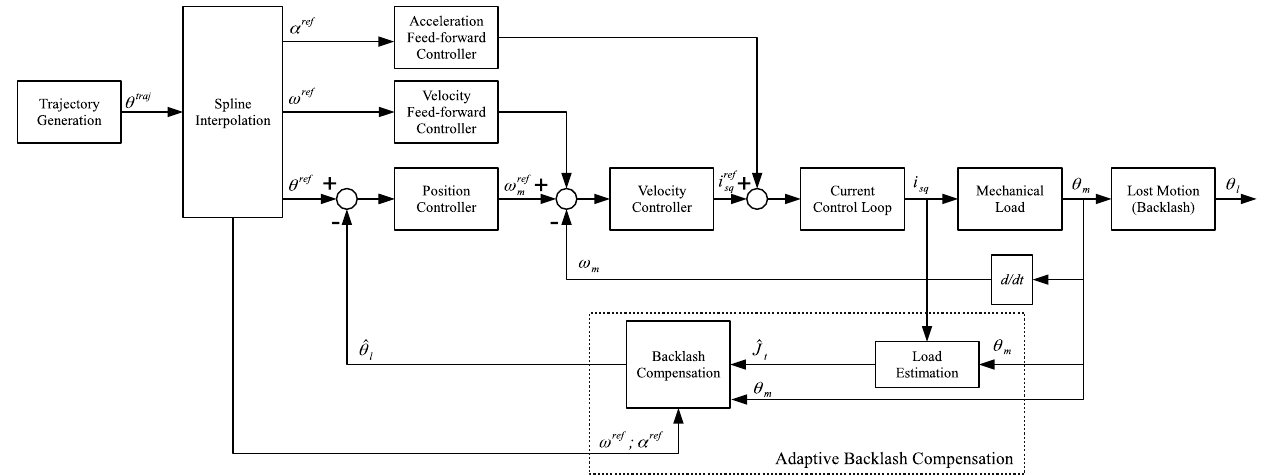
Figure 4. A block diagram of the proposed servo control system in the CNC machine